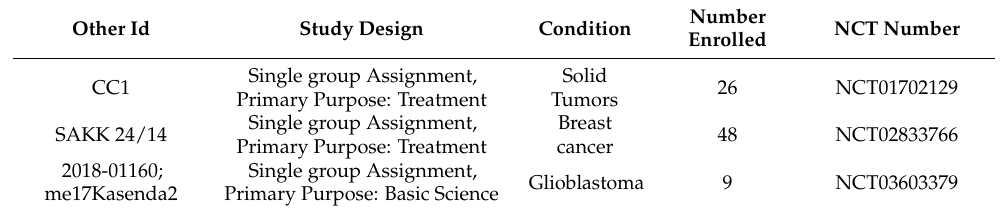
Table 3. The available clinical trials on ABC associated with drug molecules to enhance the cytotoxic- ity and effectiveness on